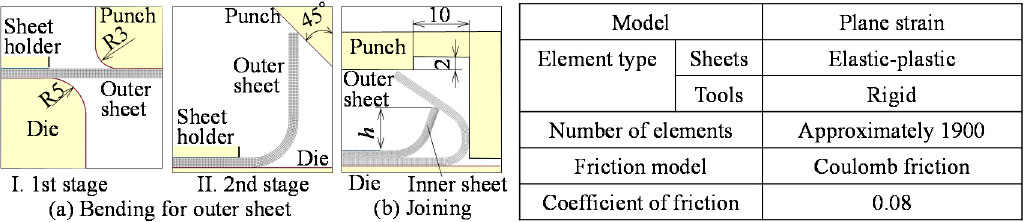
Figure 4. Calculated conditions of hemming with relaxation of deformation and compression of outer sheet.